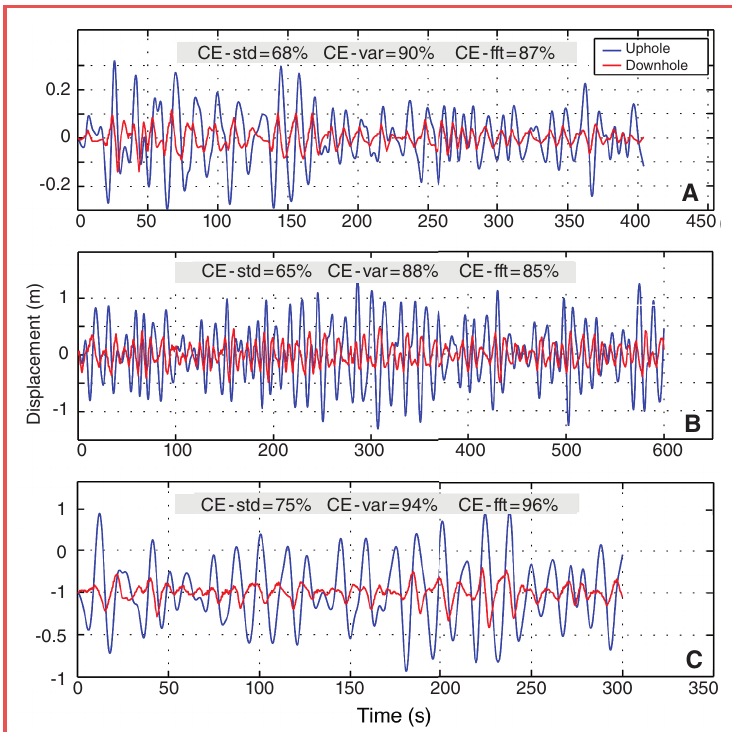
Figure 4. Best CE performances of the IODP AHC under varying water depths and sea states during stationary tests. [A] Shallow water (575 mbrf) and low heave (±0.2–0.4 m); [B] Shallow water (300 mbrf) and moderate heave (±1.0–1.5 m); [C] Deep water (4494 mbrf) and low heave (±0.5–1 m). From Liu et al.,